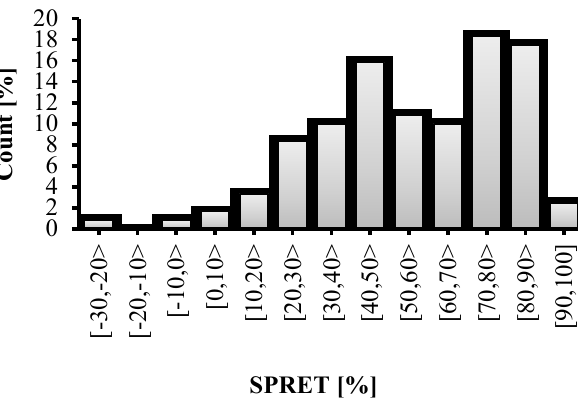
Fig. 7: SPRET percentage for each category.